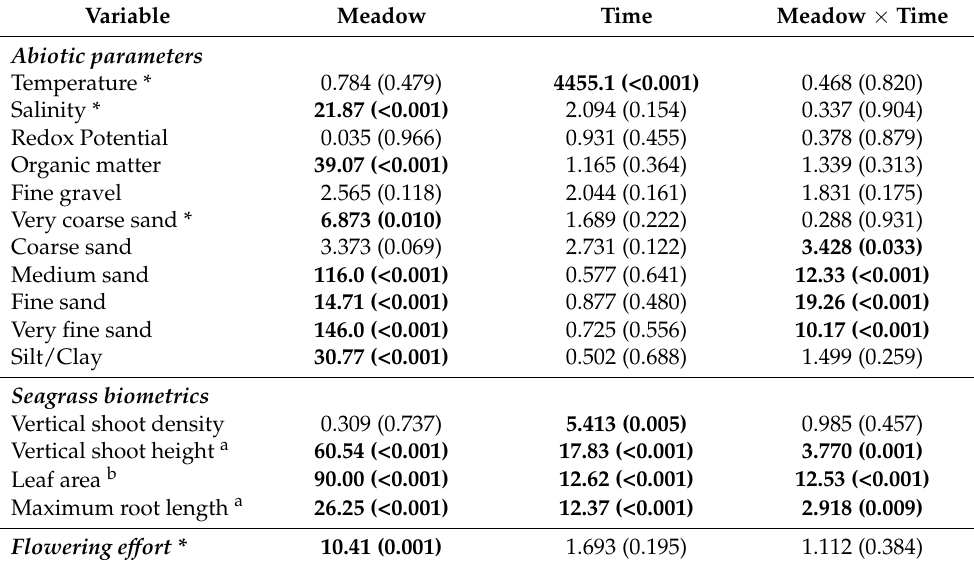
Table 1. Summary of the two-way ANOVA results [F ( p -value)], including the factors Meadow and Time , for the flowering effort, seagrass biometrics and abiotic variables. Significant differences are highlighted in bold. Asterisks over variable names indicate that data did not fit normality and/or homogeneity of the variances and significant differences among treatments were adjusted to p < 0.01. Variable Meadow Time Meadow × Time Abiotic parameters 0.784